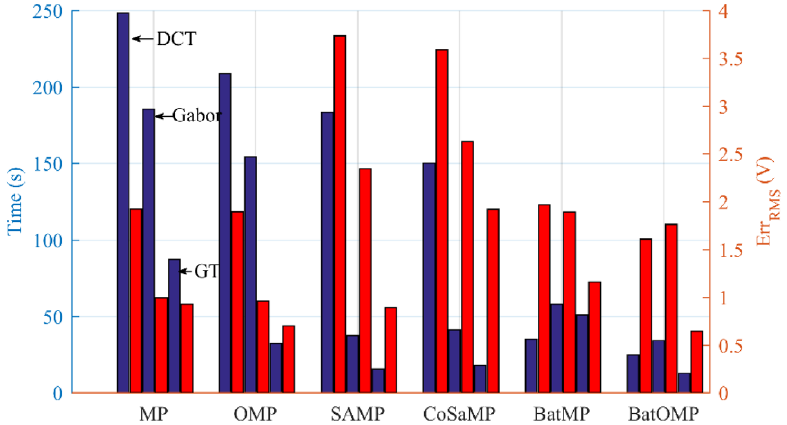
Figure 10. Quantitative analysis of experimental results. Blue bares mark the running time (the left axis) and red bars indicate the extraction errors (the right axis). For each method, the three bars of a sort from left to right represent the result of DCT, Gabor and GT dictionary respectively.